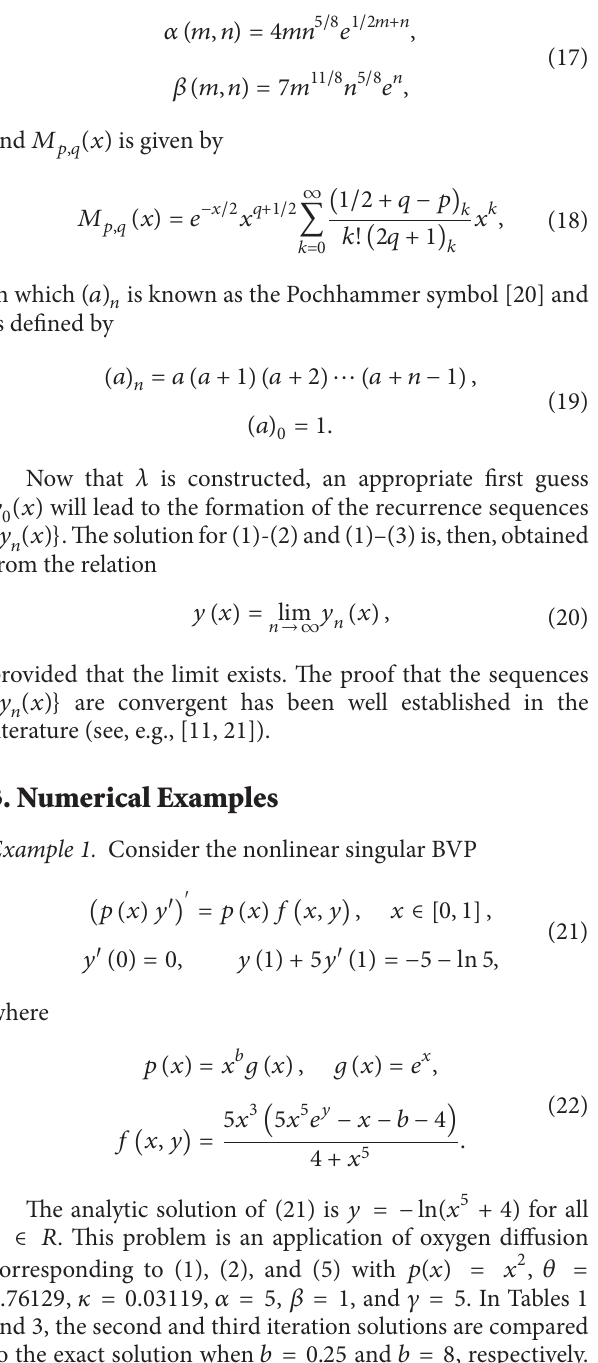
T 1: Numerical results for Example 1